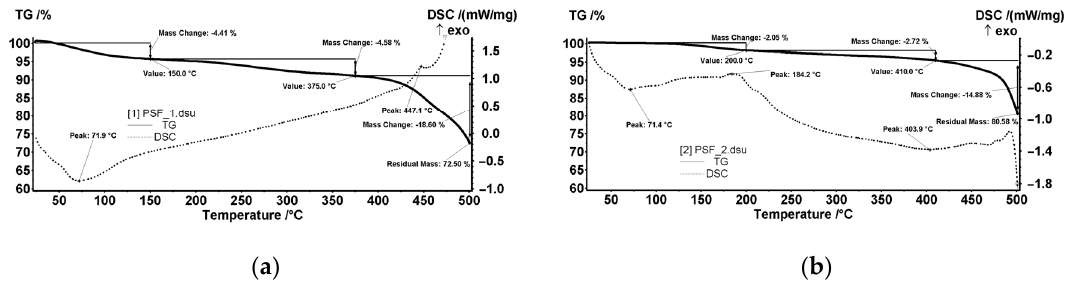
Figure 14. Weight loss (TG) and thermal e ff ects (DSC) diagrams for MPSf1 ( a ) and MPSf2 ( b ).